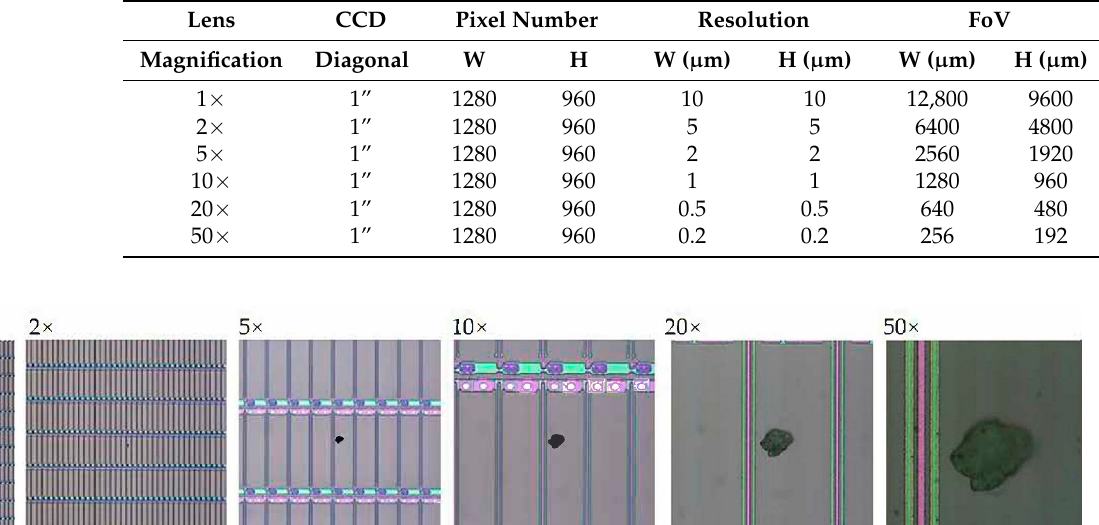
Table 3. The parameter of the field of view design in the area CCD.